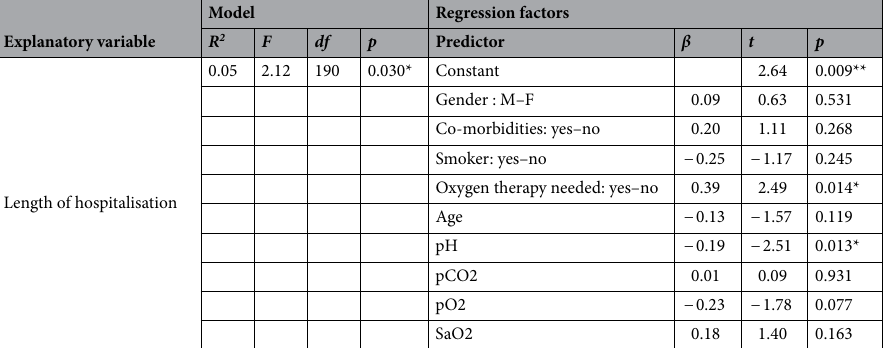
Explanatory variable